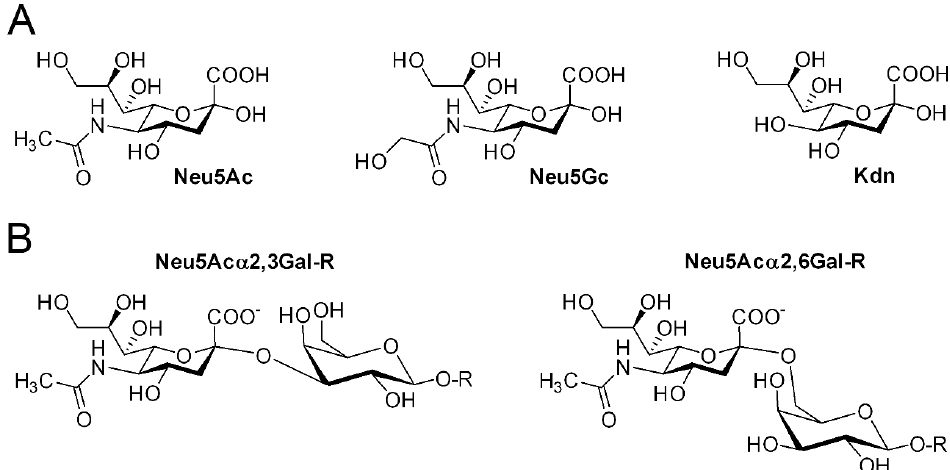
Figure 1. Sialic acids and sialylated molecules. ( A ) N -acetylneuraminic acid (Neu5Ac) is the major sialic acid molecule found in human tissues. Other commonly described sialic acids in vertebrates are N -glycolylneuraminic acid (Neu5Gc) and 2-keto-3-deoxy-nonulosonic acid (Kdn); ( B ) In vertebrates, the sialic acid hydroxyl group at position 2 is most frequently glycosidically-linked to either the 3- or 6-hydroxyl group of galactose (Gal) residues. These glycosidic linkages are formed by the β -galactoside α 2,3/6-sialyltransferases described in this review. Owing to their anionic charge and their peripheral position in glycans, SA play major roles in the various vertebrate biological systems ranging from protecting proteins from proteolysis,